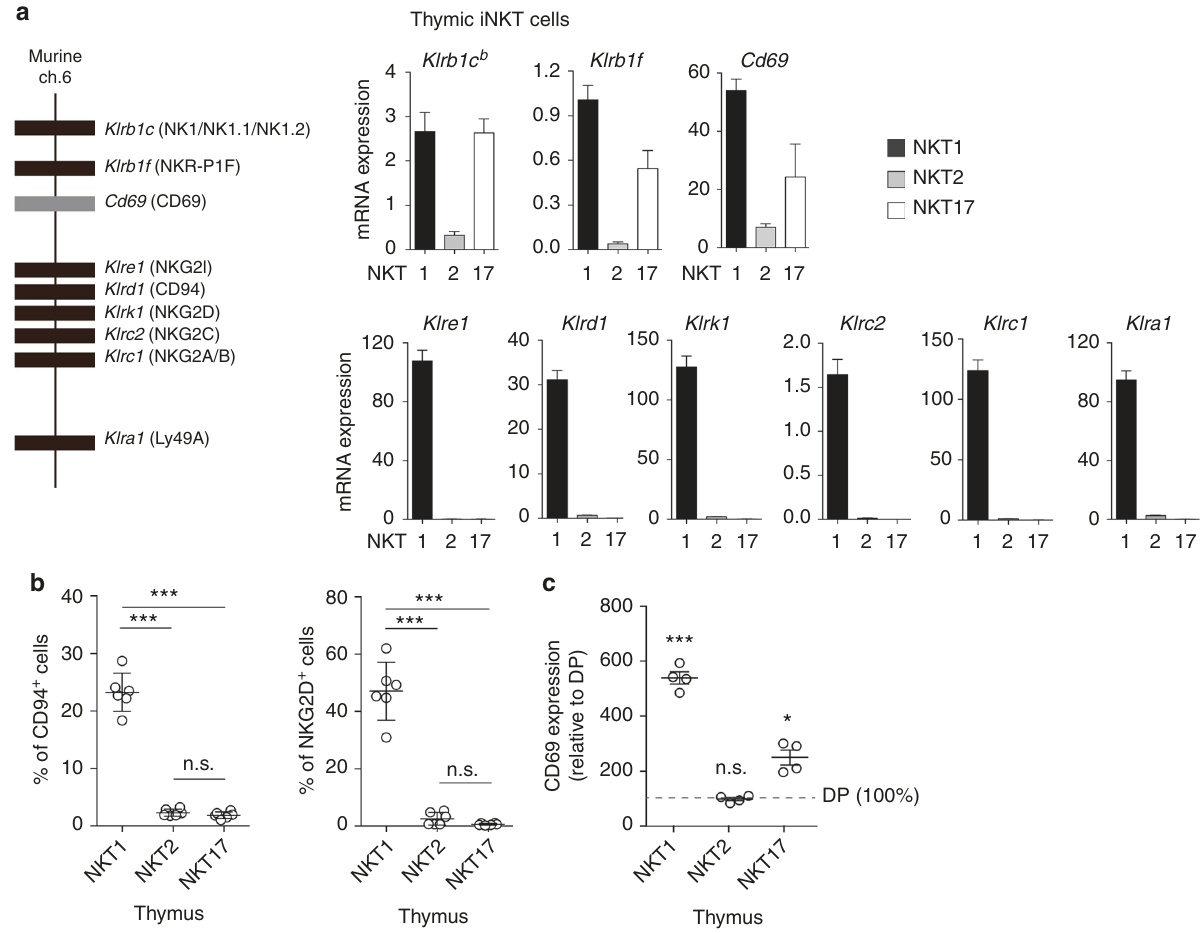
Fig. 1 NK cluster gene expression in each iNKT subset. a Murine NK cluster genes, including the Cd69 gene, are located on murine chromosome 6 (left). The mRNA expression of NK cluster genes in NKT1 (CD3 + CD1d.PBS57 low CD138 – CD44 hi ), NKT2 (CD3 + CD1d.PBS57 hi CD138 – ) and NKT17 (CD3 + CD1d. PBS57 + CD138 + ) cells sorted from BALB/c thymus and analyzed by quantitative RT-PCR. Data are shown relative to the Rpl13a expression (right). b A fl ow cytometry analysis of the frequencies of CD94 + or NKG2D + cells gated on each iNKT subset (identi fi ed as in Supplementary Fig. 1c) from BALB/c thymus. c The CD69 expression on each iNKT subset (identi fi ed as in Supplementary Fig. 1c) from BALB/c thymus presented as the mean fl uorescence intensity relative to that on preselection (TCR β lo-med CD4 + CD8 + ) thymocytes. The mean and SEM are shown. * p < 0.05 and *** p < 0.001 (one-way ANOVA). Representative data from fi ve experiments with fi ve mice are shown ( a ). Data are pooled from two experiments with six mice ( b ) and three experiments with four mice ( c ). n.s. not signi fi